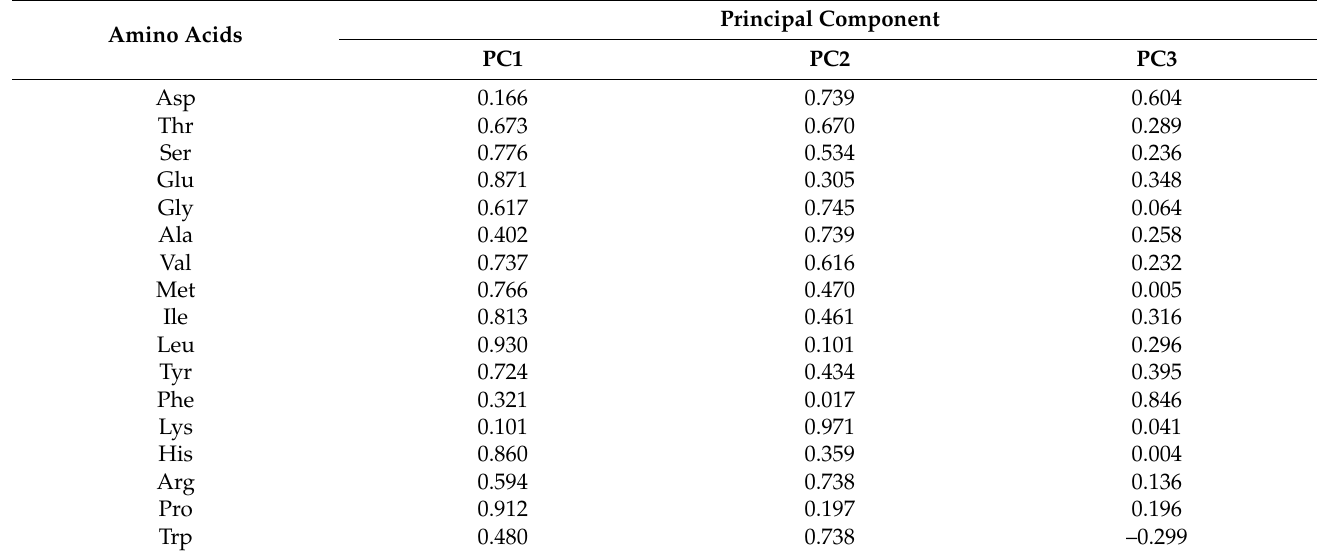
Table 18. Rotational component matrix of the factor